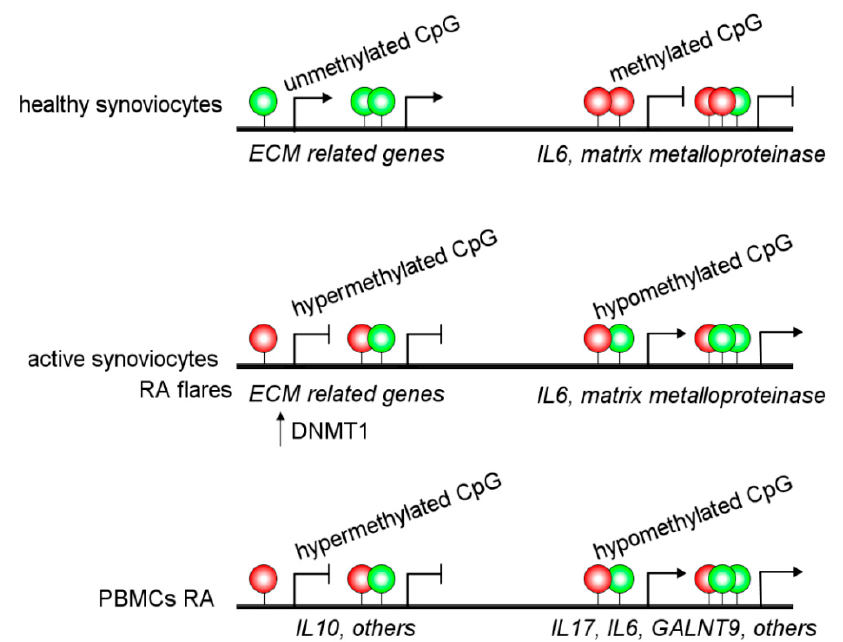
Figure 2. DNA methylation landscape in Rheumatoid Arthritis. Synoviocytes and peripheral blood mononuclear cells (PBMCs) from RA patients display an altered DNA methylation status, including hypomethylated (green circles) and hypermethylated (red circles) CpG sites. Both synoviocytes and PBMCs, display a predominant hypomethylated gene pattern compared to healthy controls. Gene expression of proinflammatory cytokines, such as IL6 and IL1 and extracellular matrix (ECM) degrading enzymes, such as metalloproteases were markers of active RA.